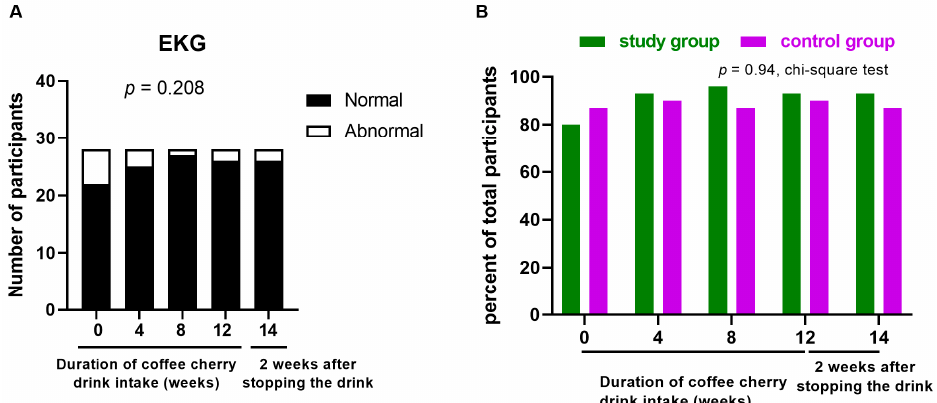
Data are expressed as the number of participants with abnormal values, n , (values) Abbreviations: WBC, white blood cell; RBC, red blood cell, HP, high power field.